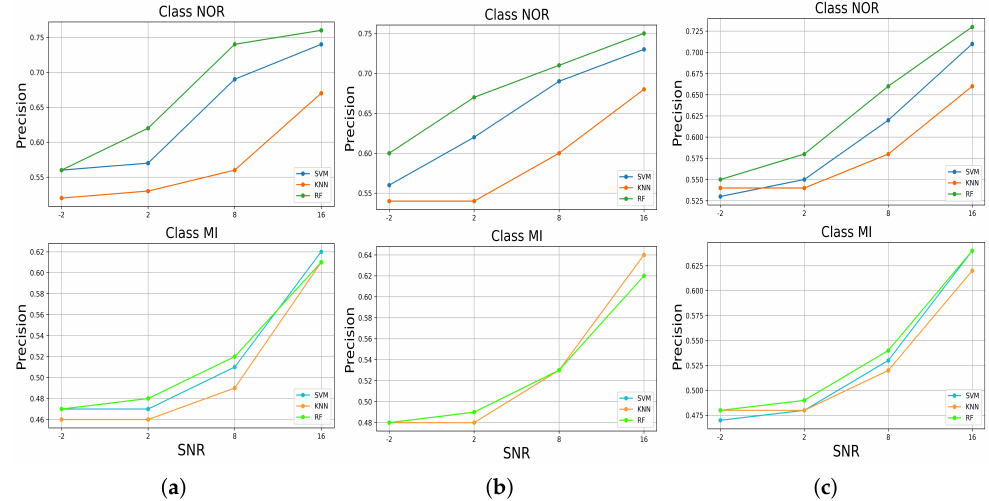
Figure 9. The precision performance of predicting the classes of the signal with added noises by the trained models, ( a ) for added muscle artifact noise, ( b ) for added electrode motion noise, ( c ) for added baseline wander noise.